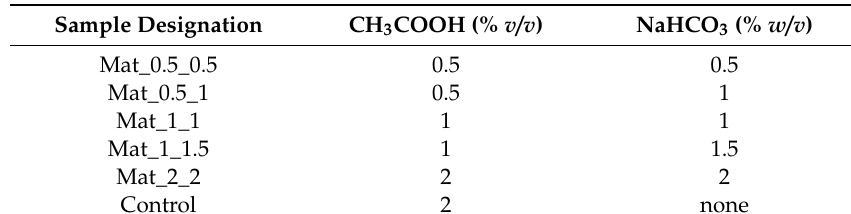
Table 1. Concentrations of solvent (CH 3 COOH) and gas-foaming agent (NaHCO 3 ) which were applied during fabrication process of the scaffolds.